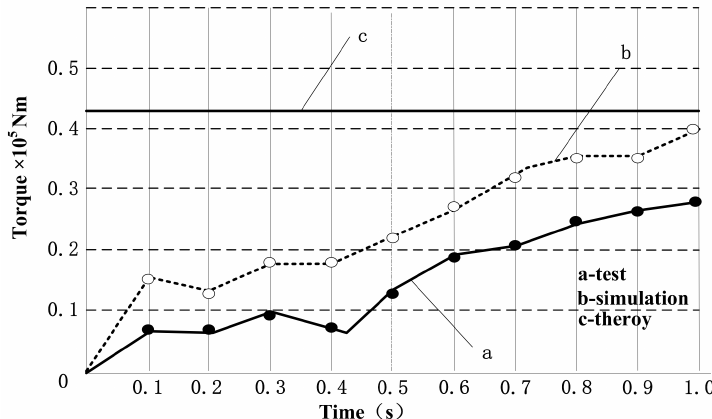
Figure 16. Torque of three rotary speeds.